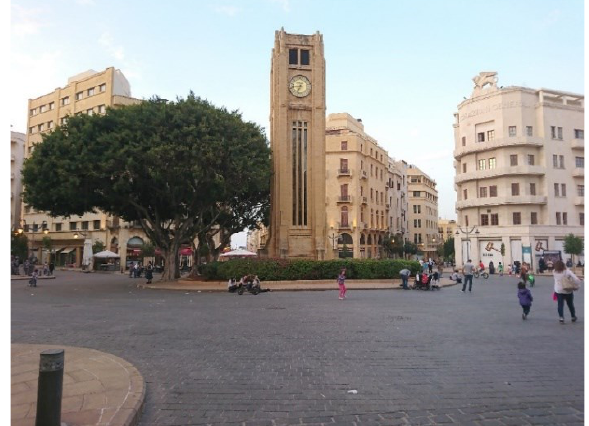
Figure 7. The Nejme Square, close to the Martyrs’ Square, Downtown, Beirut (Maria A. El Helou photo